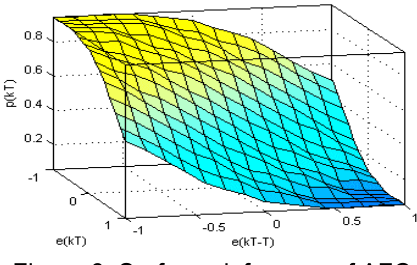
Figure 6. Surfaces inference of